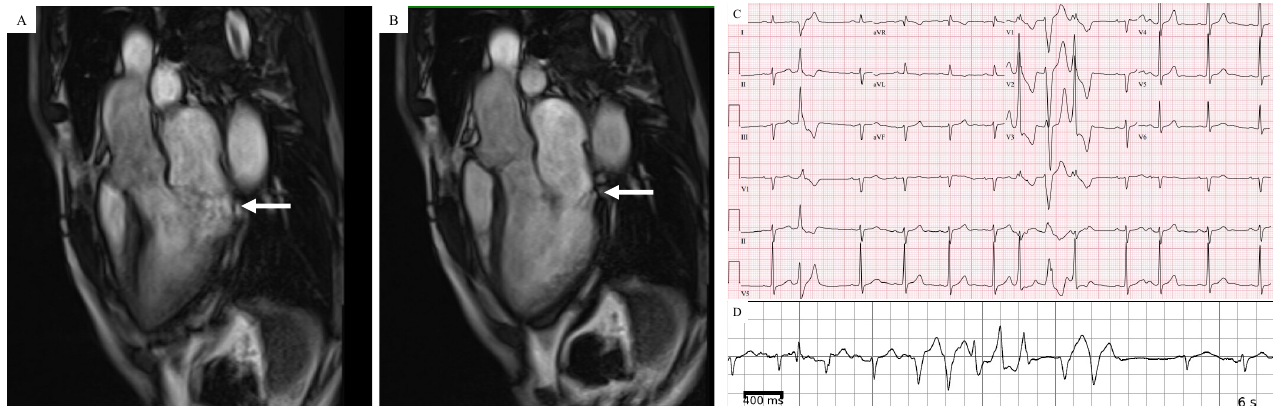
Figure 4. Patient with AMVP who has evidence of mitral annular disjunction (MAD) by CMR in a 3-chamber long-axis view in systolic frame ( A ) and diastolic frame ( B ). ( C ) 12-lead ECG showing PVCs with alternating axes. ( D ) Complex ventricular ectopy captured on ambulatory ECG monitoring.